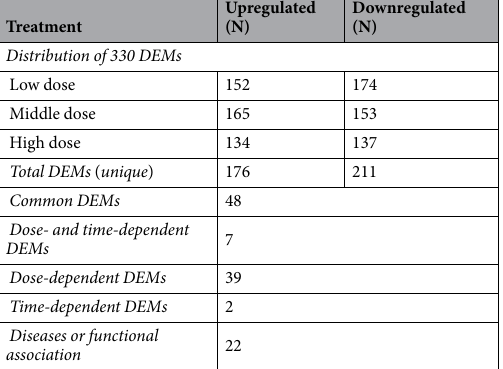
Table 1. Summary of the results obtained from the bioinformatics workflow.